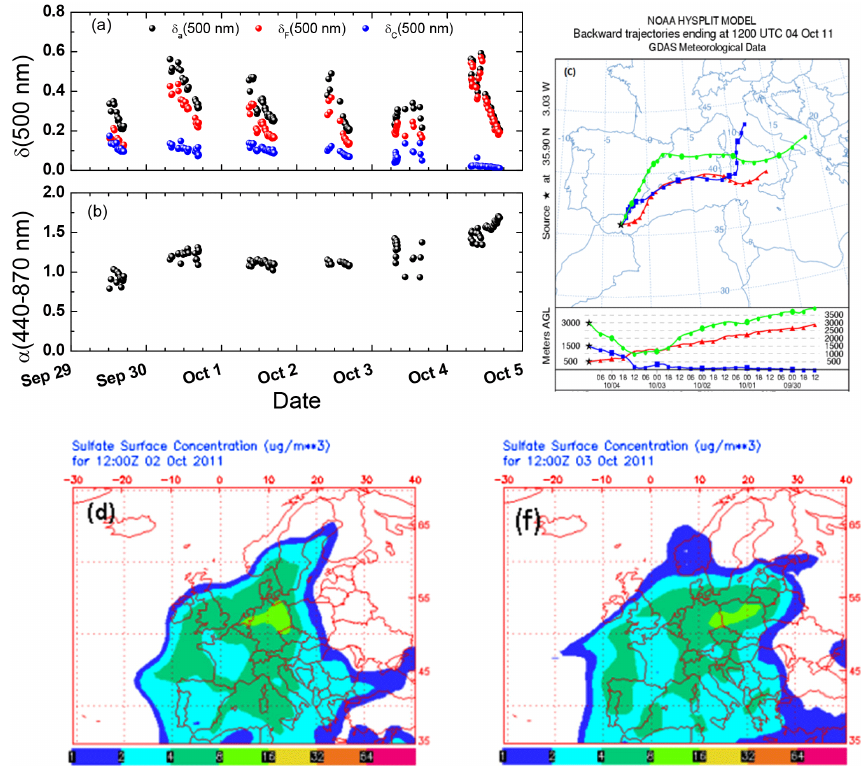
Figure 4. (a) Total, fine and coarse aerosol optical depths at 500nm and (b) Ångstrom exponent in the range 440–870nm obtained at Alborán Island during 29 September–5 October 2011. (c) Backward trajectories ending at 12:00 UTC on 4 October 2011 over Alborán Island at altitudes of 500, 1500 and 3000m. (d) and (f) NAAPS maps for sulfate surface concentrations for 2 and 3 October 2011 at 12:00